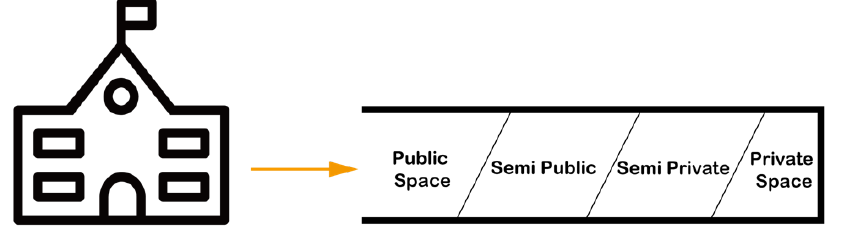
Figure 12. The Property of Territory Transformation Idea in a School Facility. Table 4. Transformation Analysis of Territory Function.